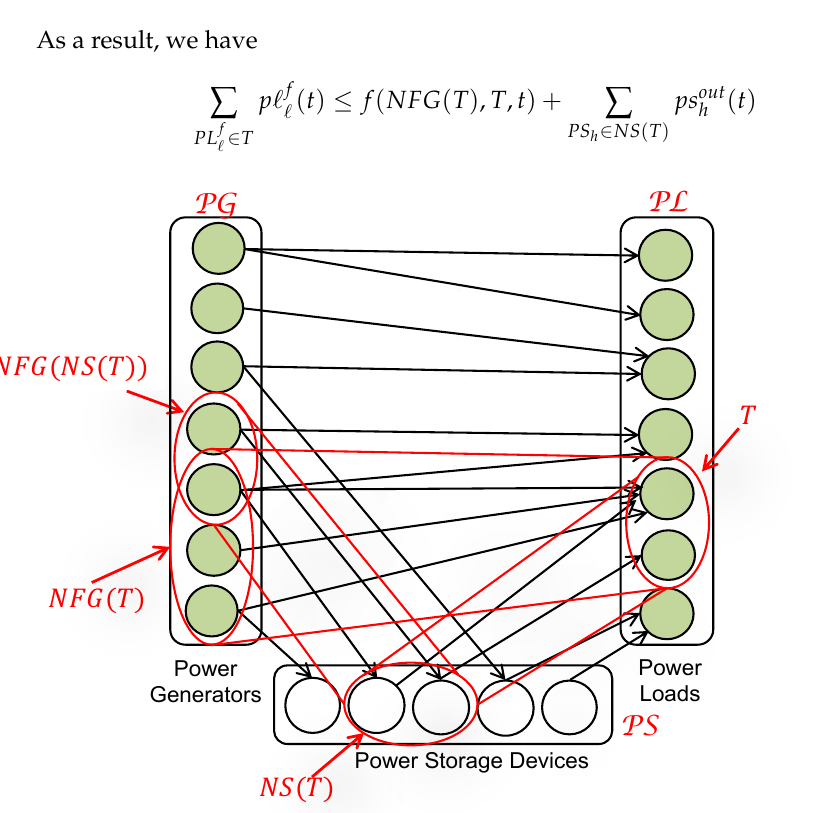
Figure 8. Subset T of power loads and the neighbor connected set of power